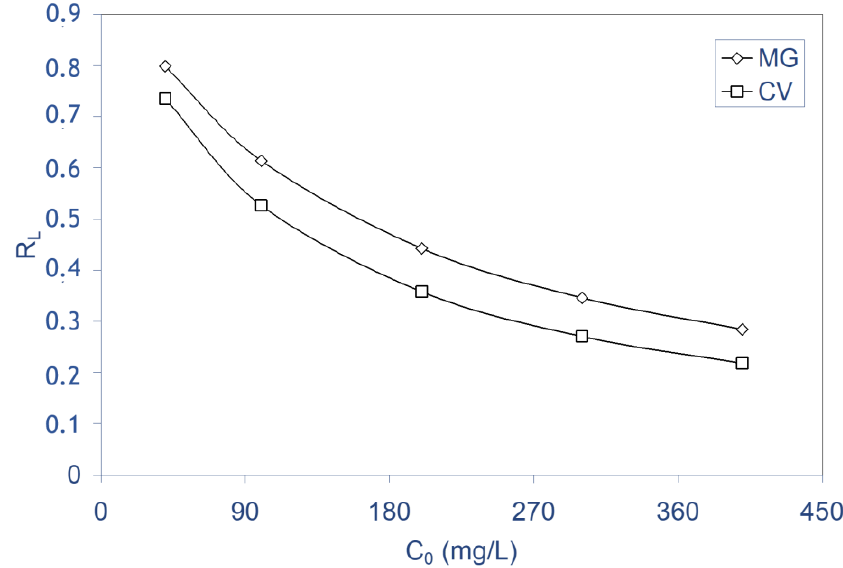
Figure 11. Separation factor (R L ) for the biosorption of MG and CV on ALP at 298 K.